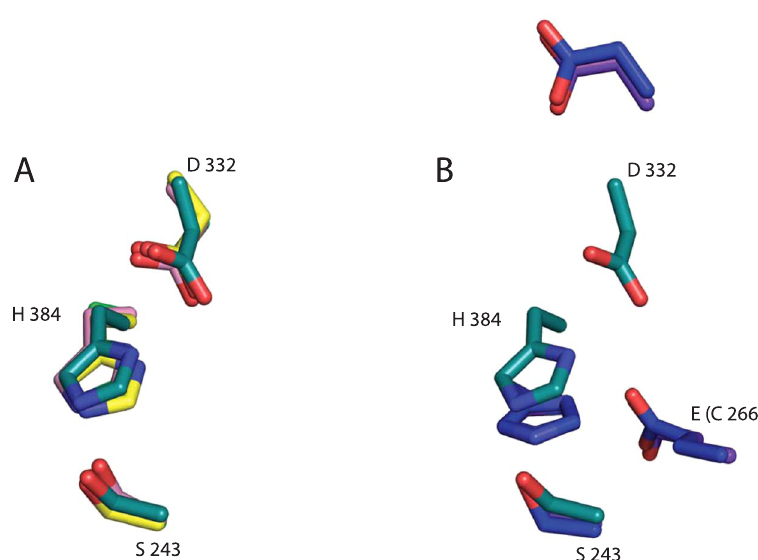
Figure 4. ( A ) Active site residues of MZ0003 (teal) superimposed onto the catalytic triads of the feruloyl esterase of B . proteoclasticus (pink) and the TT1662 esterase from T . thermophilus HB8 (yellow). ( B ) MZ0003 (teal) superimposed onto the catalytic triads of M . thermophilia StGE2 (blue) and H . jecorina Cip2 (purple- overlaped by